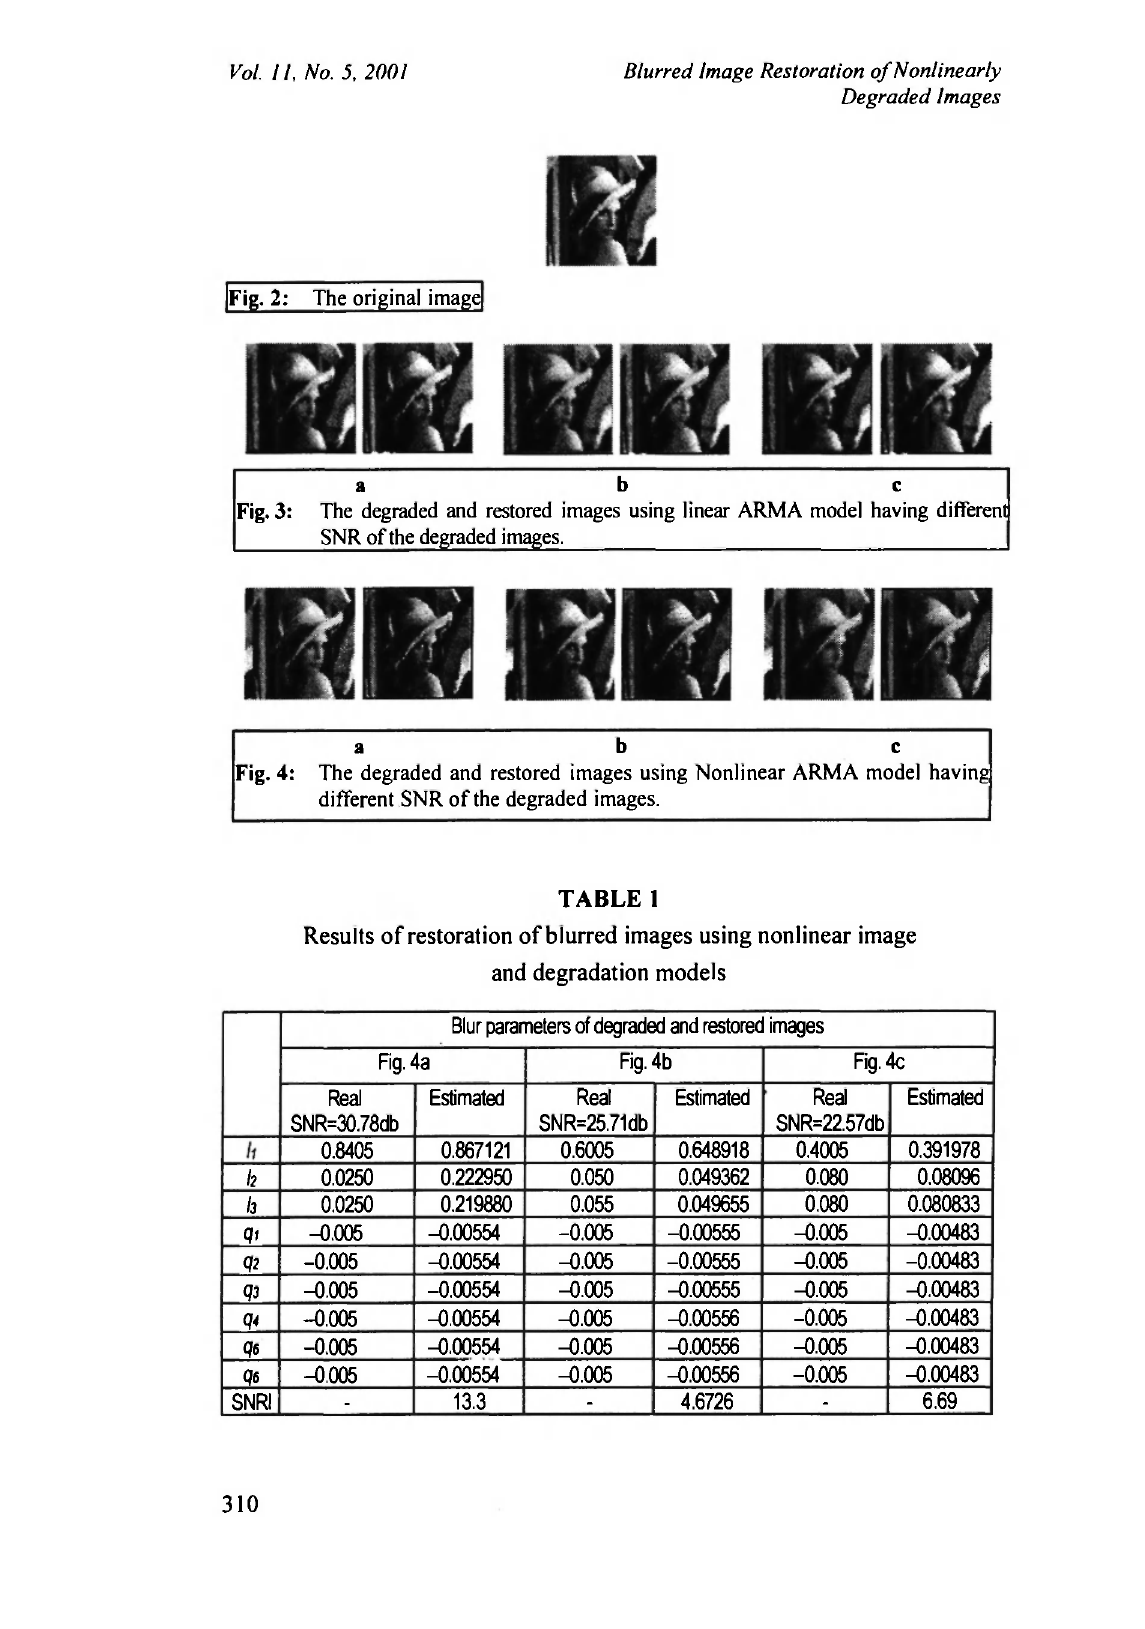
Fig. 2: The original image